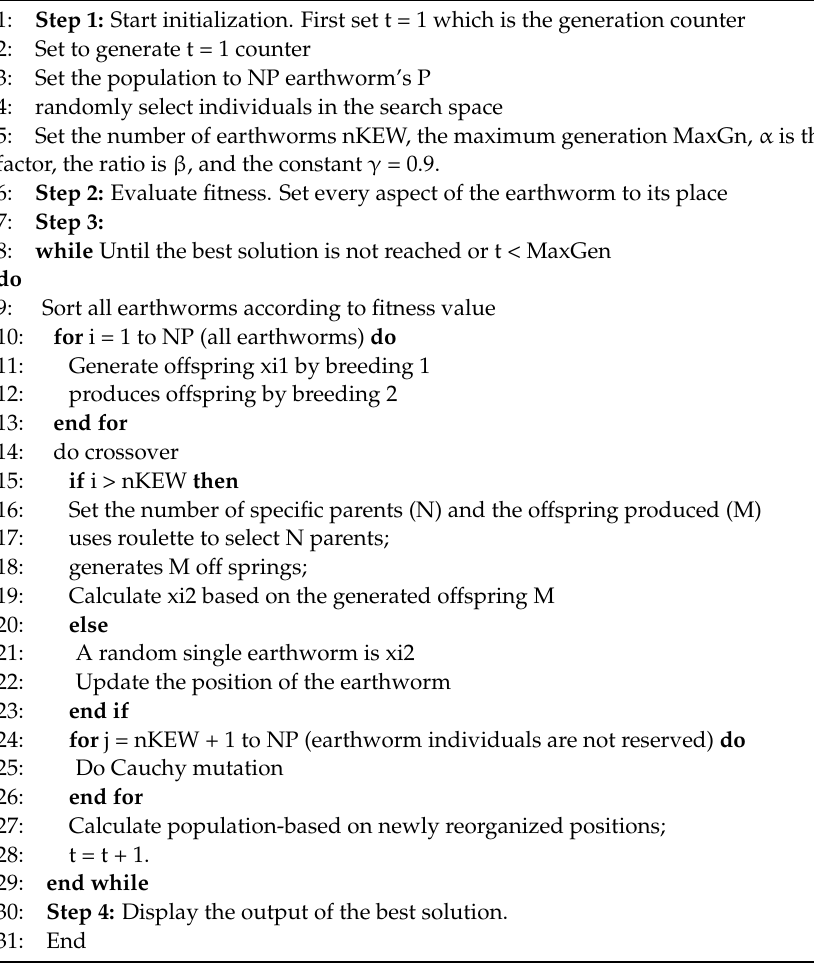
Algorithm 1. EWA for SG